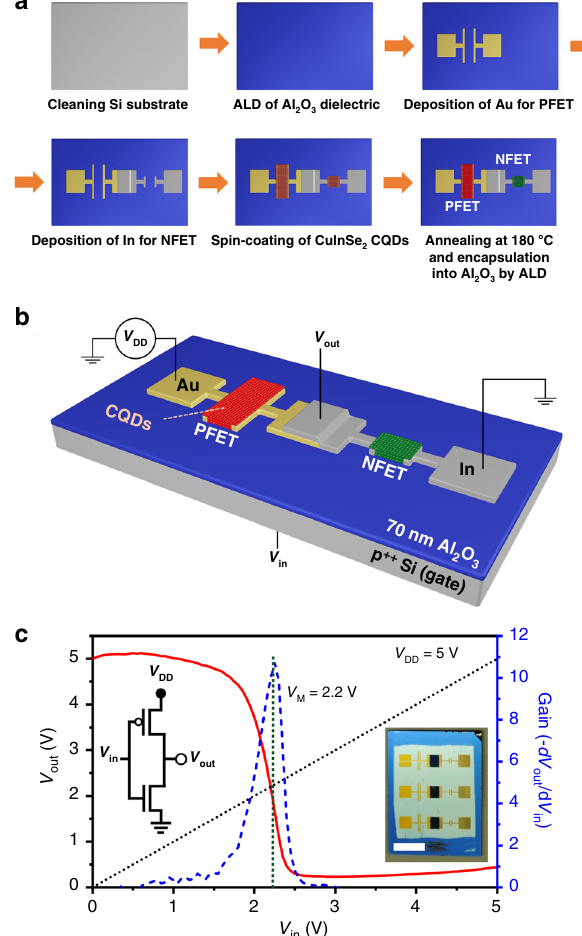
Fig. 4 CuInSe 2 -CQD-based inverter realized using complimentary p - and n -channel FETs. a Processing steps used to fabricate a complementary metal-oxide-semiconductor (CMOS) inverter based on p - and n -channel CuInSe 2 CQD FETs (PFET and NFET, respectively). After cleaning a p ++ Si substrate (gate electrode), we deposited a 70-nm layer of Al 2 O 3 by ALD to serve as a gate dielectric. Gold and then indium source and drain electrodes were deposited via thermal evaporation to de fi ne the PFET and NFET, respectively. The PFET and NFET channel widths are 3 and 1mm, respectively. The channel lengths are the same (100 µ m) for both FETs. The CuInSe 2 CQD layer was deposited onto the substrate with the prepatterned electrodes via sequential spin-coating and ligand exchange using NH 4 I/methanol followed by washing with methanol. The device was then annealed at 180°C to allow for indium diffusion into the CQD layer within the NFET channel. Finally, the device was encapsulated in a thin layer of Al 2 O 3 by ALD. b The schematic depiction of the fabricated CQD CMOS inverter (not to scale). CQDs form a continuous fi lm on top of a substrate with prepatterned PFET and NFET electrodes and connecting metal circuits that de fi ne the device function. The red and green areas show the region of the CQD fi lm that act as, respectively, p - and n -type channels. c The voltage-transfer characteristic (VTC) of this device for V DD = 5V (solid red line). The dotted black line corresponds to V = V fi rst derivative of the VTC. Inset is a out in . The dashed blue line is the top-view photograph of the substrate with three inverters (scale bar is 5mm). Source data are provided as a Source Data fi